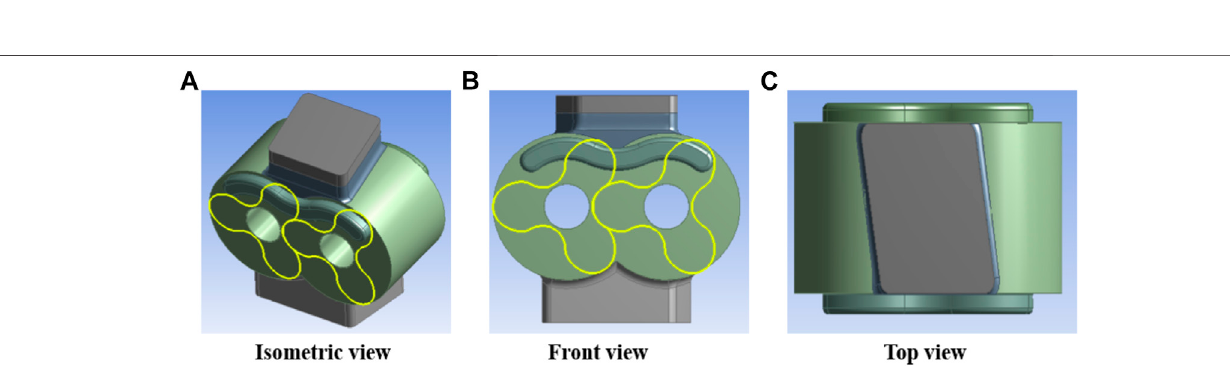
FIGURE 9 | Pressurization in the transfer volume before opening to the outlet port at 5,000 rpm and PR-1.3. (A) Without back fl ow port design. (B) One-side back fl ow port design. (C) Two-side back fl ow port design.